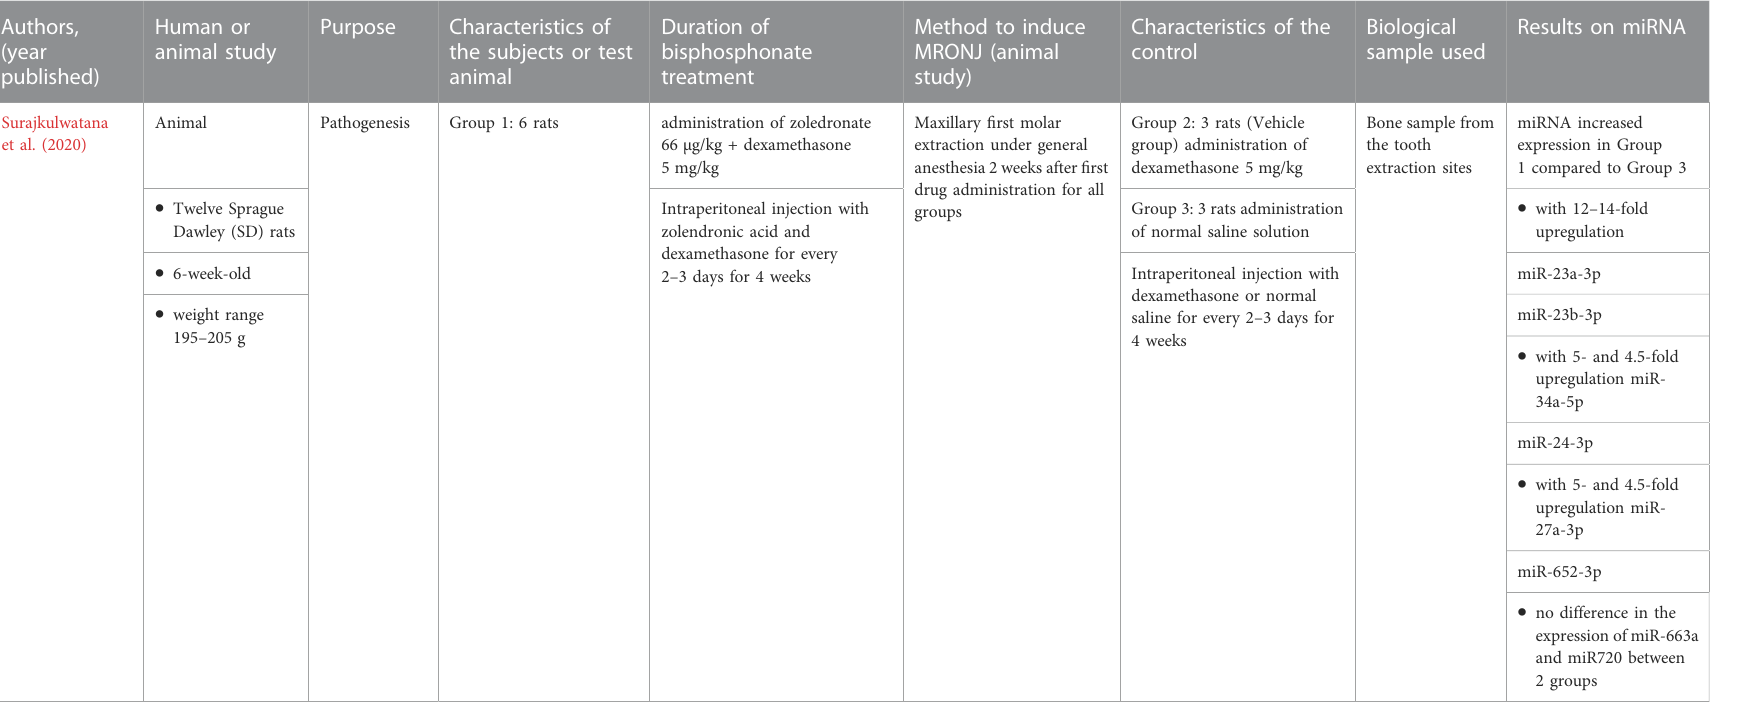
Abbreviation: MRONJ: medication related osteonecrosis of the